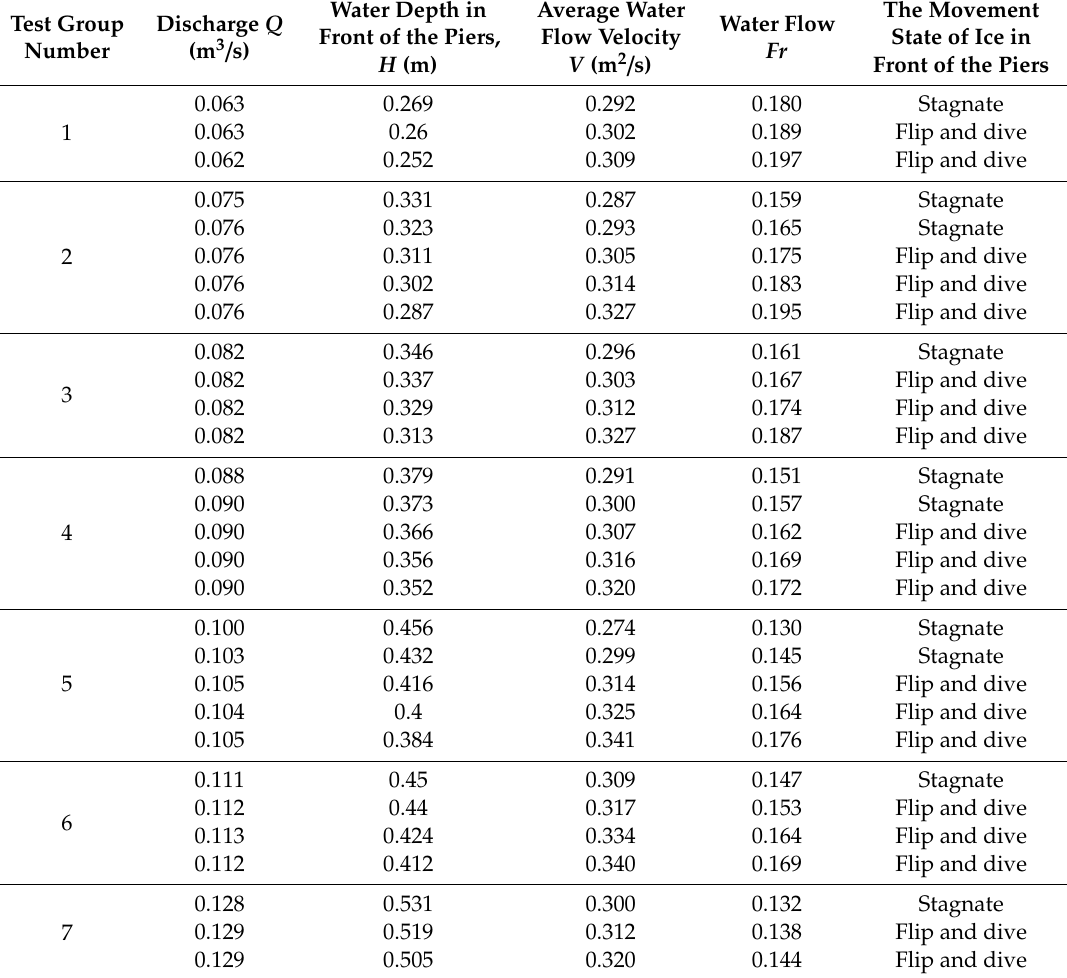
Table A1. When L = 0.16 m and t = 0.03 m, The movement state of ice in front of the piers under di ff erent water flow conditions (ice block in contact with the pier columns at 45 ◦